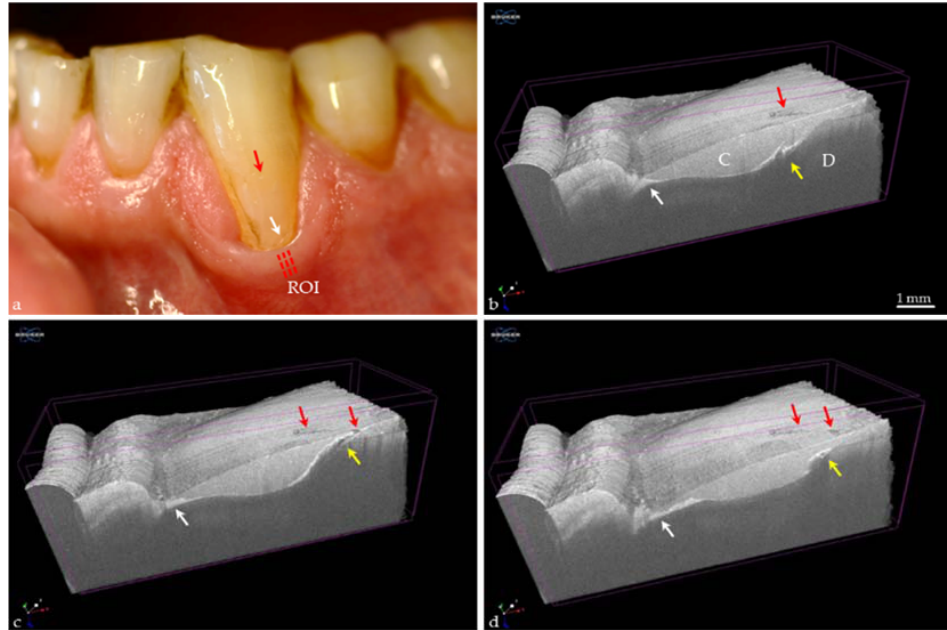
Figure 18. OCT quality control in vivo. 3D OCT imaging of a cervical composite (C) restoration at a premolar after filling the cavity in small increments ( a – d ). Images ( b – d ) show the image stack using a sequence of three OCT B ‐ scans in y ‐ direction (ROI shown in a ). The bright lines at the tooth ‐ composite interface demonstrate a margin gap at dentin (D) and extended interfacial bond failures (white arrows). Additionally, communicating bubbles are clearly evident (yellow arrows) and reach the restoration surface, forming an entrance for material to penetrate into the restoration ( a – d , red arrows).